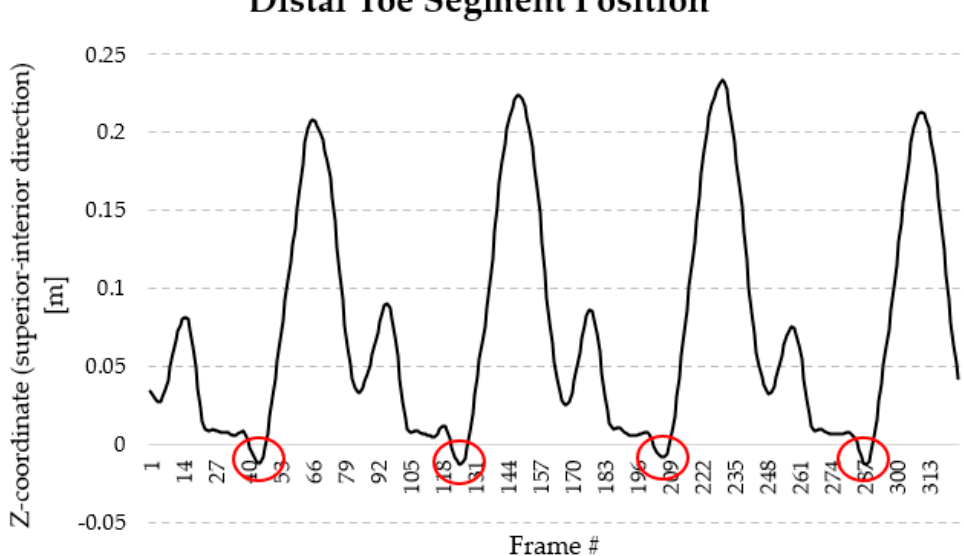
Figure 2. The toe-off gait event was determined for each footfall utilizing the distal endpoint of the toe segment derived from the ML motion capture data. A two-frame offset preceding the local minima (red circle) of the Z-coordinate position was tagged as toe off.